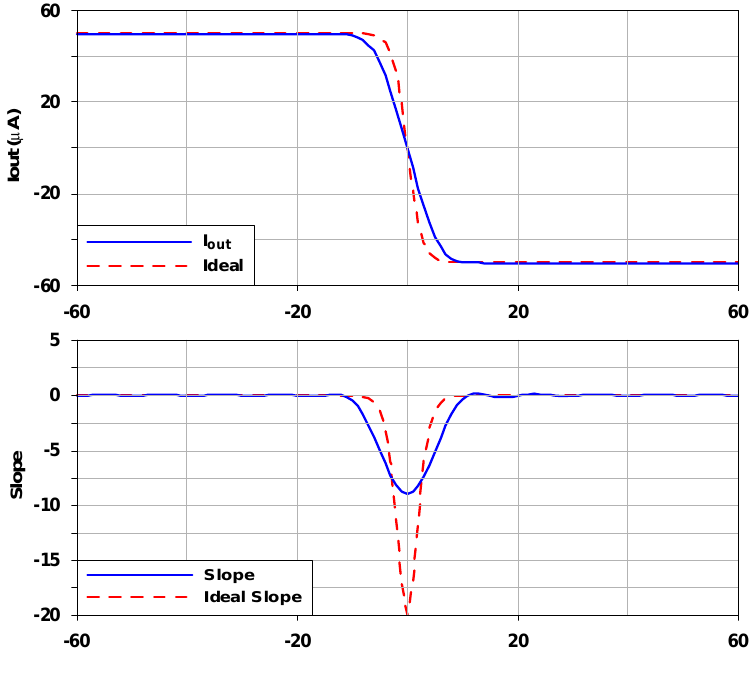
Figure 8. (Top) Logistic circuit operation compared to an ideal behaviour. (middle) Slope difference. (Bottom) Output